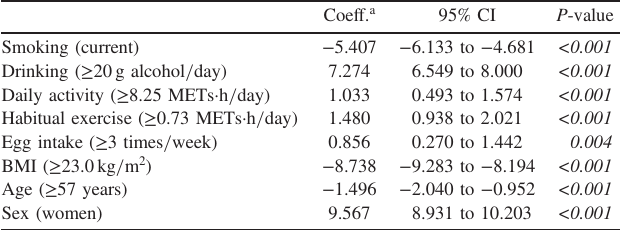
Table 2. Association between HDL-C levels and environmental factors determined in multivariate regression analysis Coe ff . a